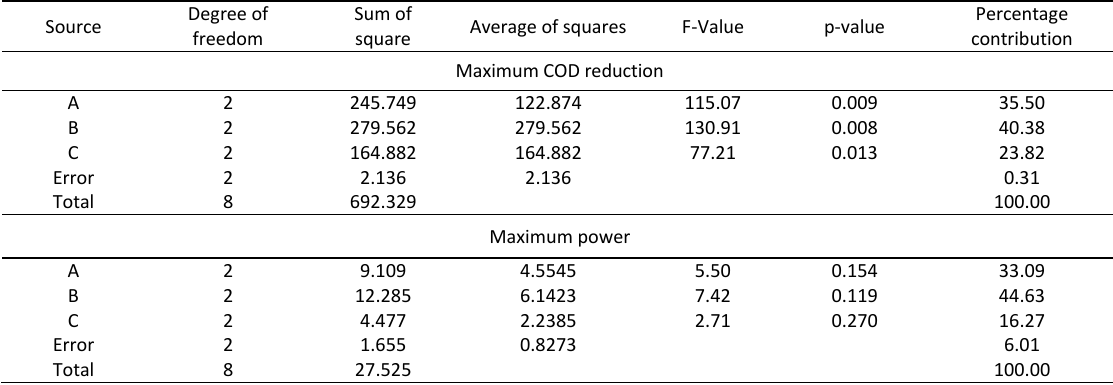
Table 7: Analysis of variance (ANOVA) for maximum power and COD reduction